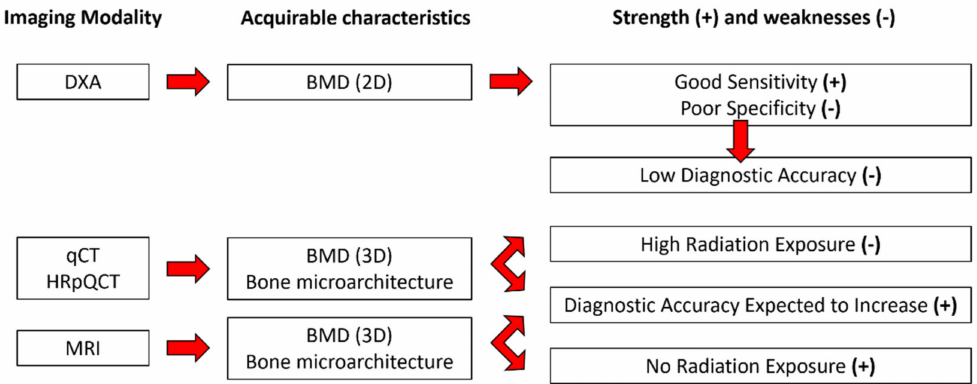
Figure 1. Available characteristics from each imaging modality with their corresponding strength (+) and weaknesses